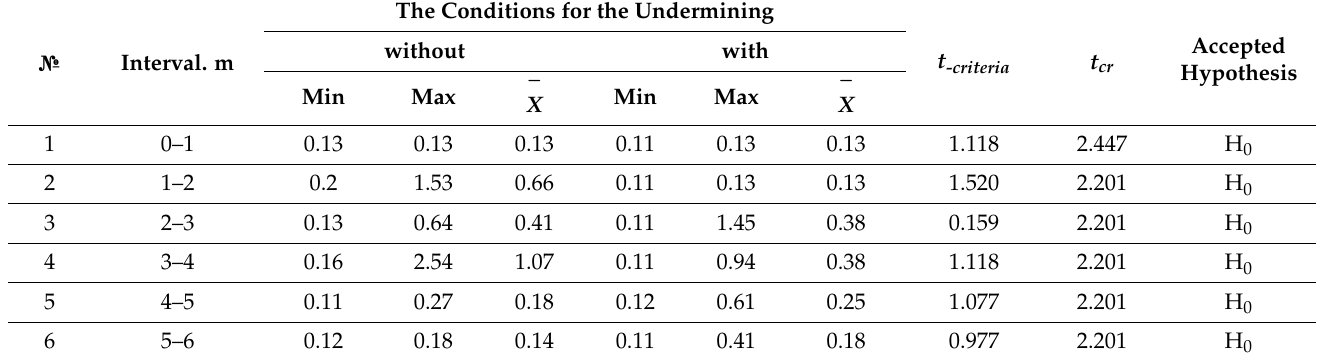
Table 3. The results of the statistical analysis of the experimental studies of the gas content of the camera roof.